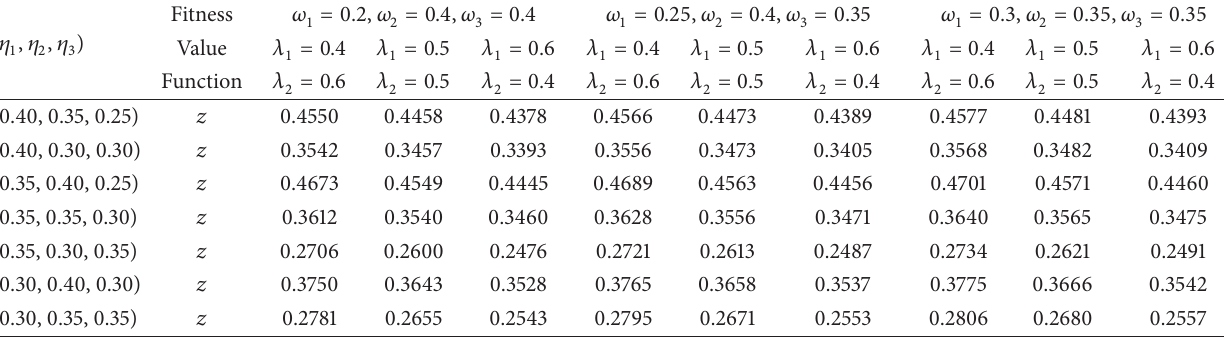
Table 11: Sensitivity analysis on the weights selection by project managers.